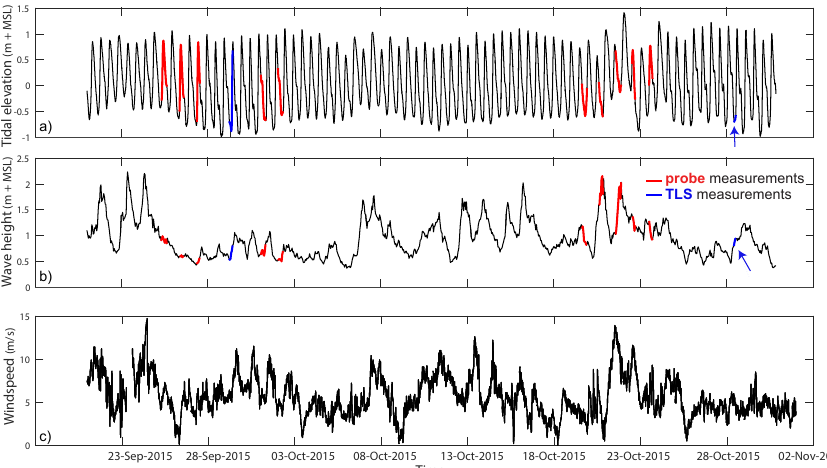
Figure 5. Time series of offshore ( a ) water level, ( b ) significant wave height and ( c ) wind speed from 21 September until 2 November 2015 measured at IJmuiden (approximately 15 km to the south of Egmond). The red line represents conditions during Theta probe measurements and the blue line during TLS